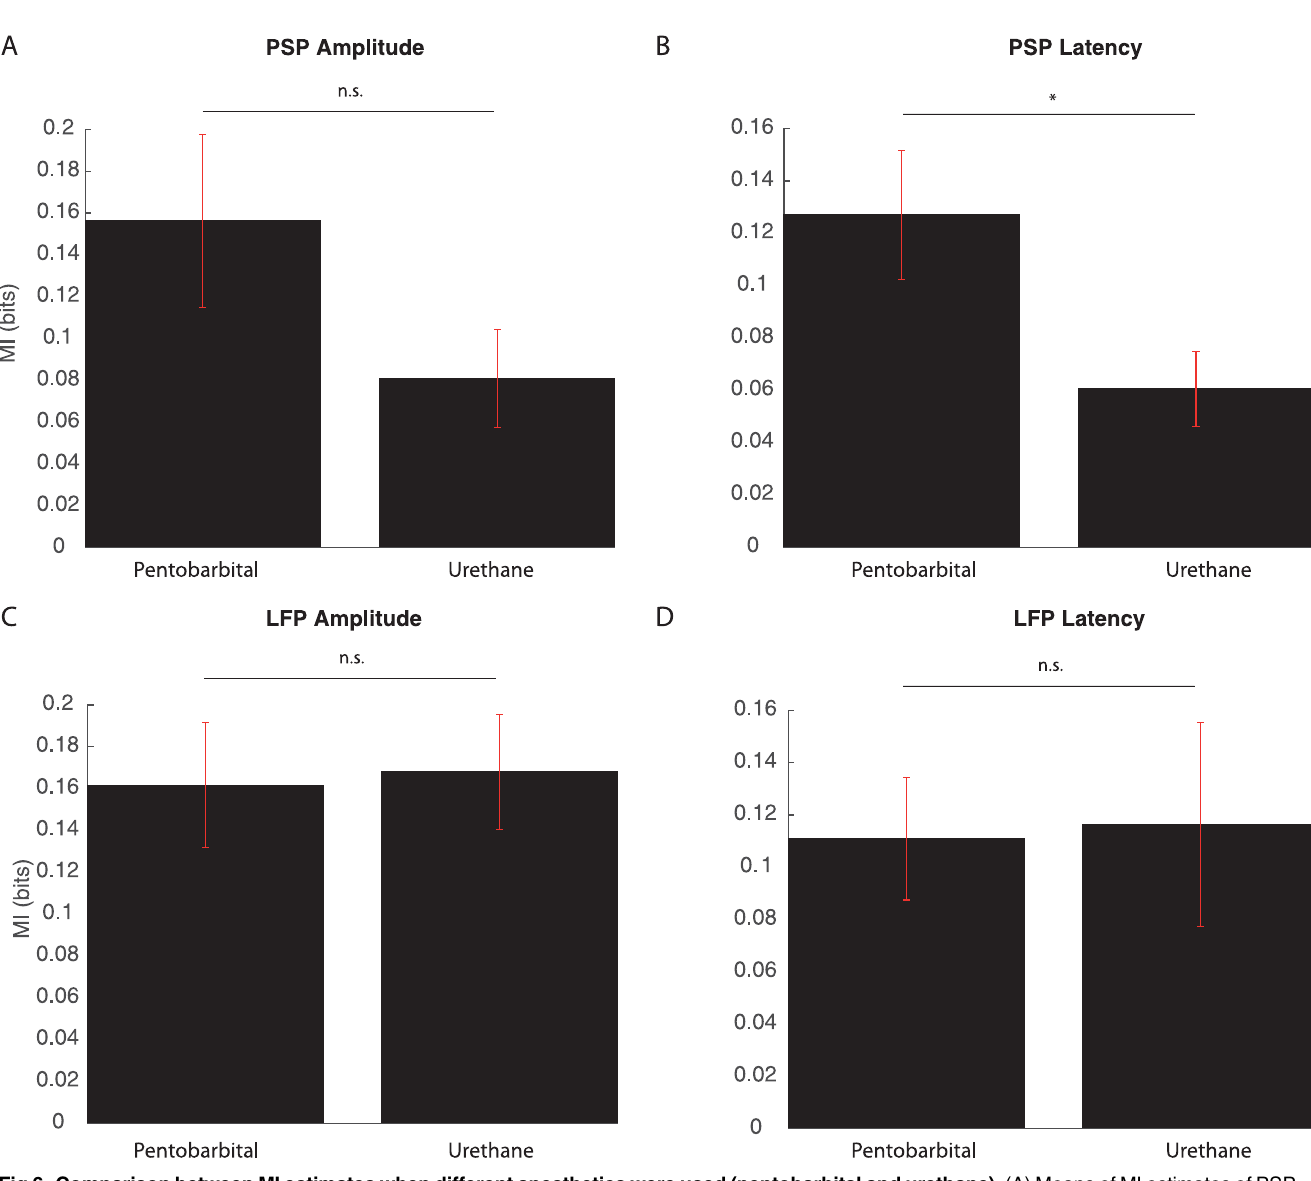
Fig 6. Comparison between MI estimates when different anesthetics were used (pentobarbital and urethane). (A) Means of MI estimates of PSP amplitudes, Wilcoxon rank-sum test indicated no significant difference ( p = 0.103). (B) Means of MI estimates of PSP latencies, Wilcoxon rank-sum test indicated significant difference ( p = 0.021) (C) Means of MI estimates of LFP amplitudes, Wilcoxon rank-sum test indicated no significant difference ( p = 0.388). (D) Means of MI estimates of LFP latencies, Wilcoxon rank-sum test indicated no significant difference ( p = 0.708). In all cases, red lines indicate